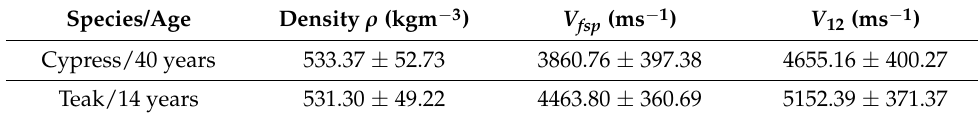
Table 2. Set of all determining properties at 12% MC ( ρ , V fsp , V 12 ) for cypress and teak. Species/Age Density ρ (kgm − 3 ) Cypress/40 years